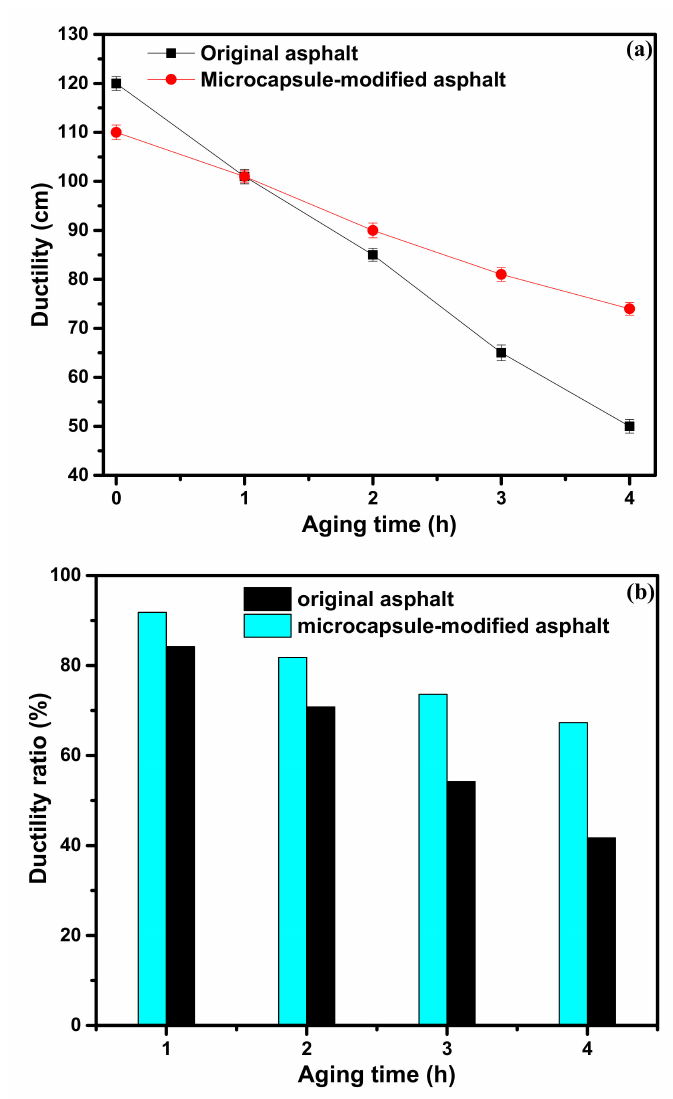
Figure 9. The ductility versus the aging time of different asphalt samples ( a ); the ductility ratio versus aging time of different asphalt samples ( b